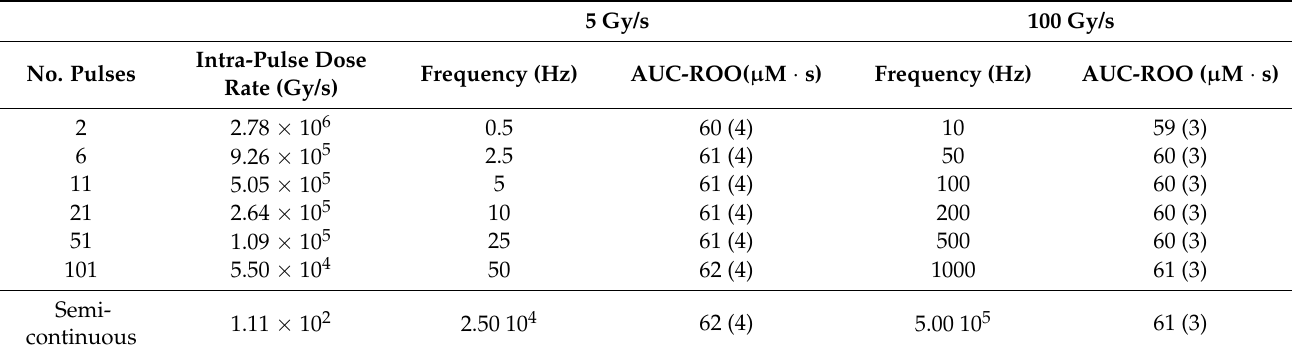
Table 3. Integral production of the ROO • radical for mean dose rates of 5 and 100 Gy/s and corresponding irradiation parameters used in the simulations of different pulse repetition frequencies, keeping the pulse width to 1.8 µ s. Reported data uncertainties correspond to one standard deviation. 5 Gy/s 100 Gy/s